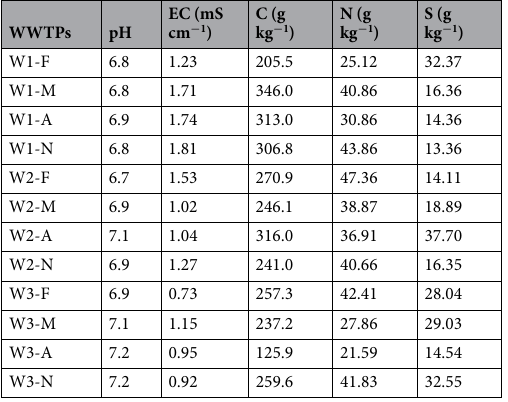
Table 1. Physicochemical characterization of wastewater and sludge samples during the four